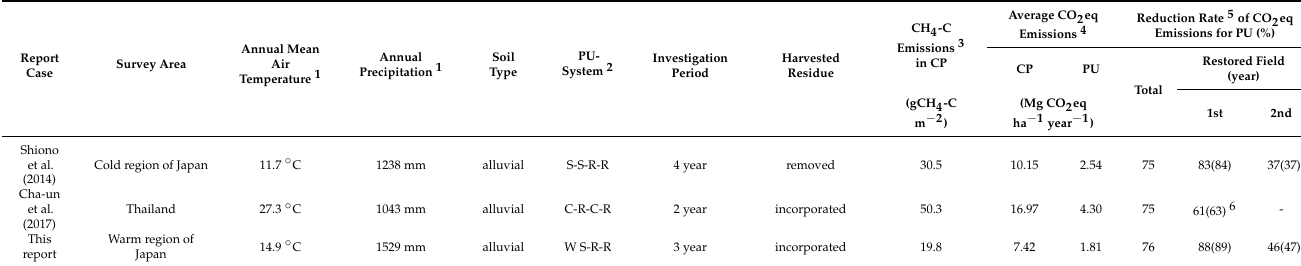
Table 5. Comparison of previous studies on GHG emission in